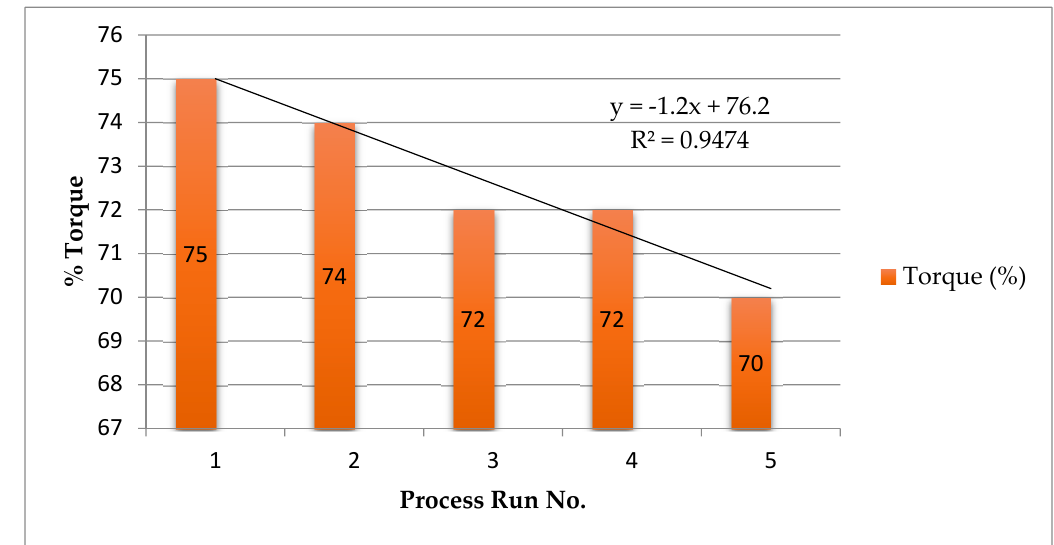
Figure 1. Extruder torque readings observed during re-processing of novel SSB ® 55 Pharma grade Shellac.